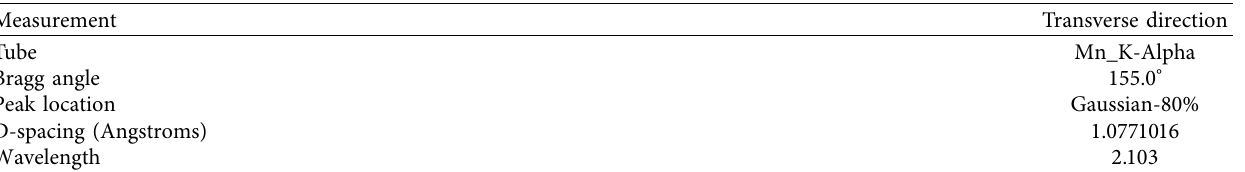
Table 4: XRD measuring